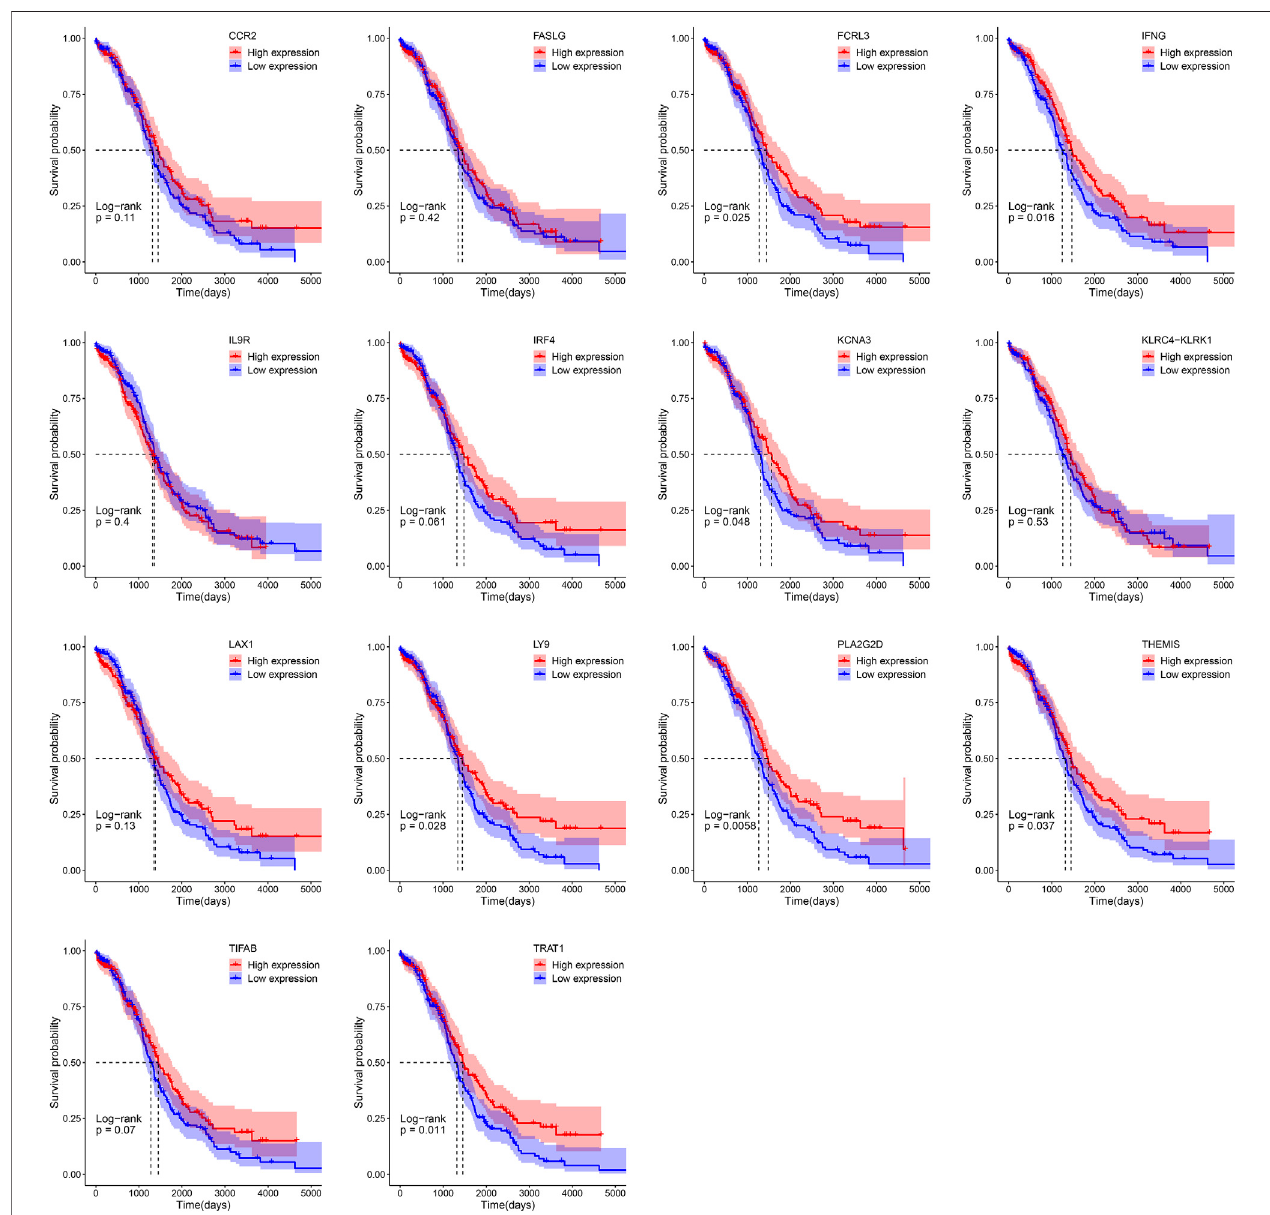
FIGURE 5 | Survival analysis of 14 key genes in OV based on the Kaplan-Meier plotter.